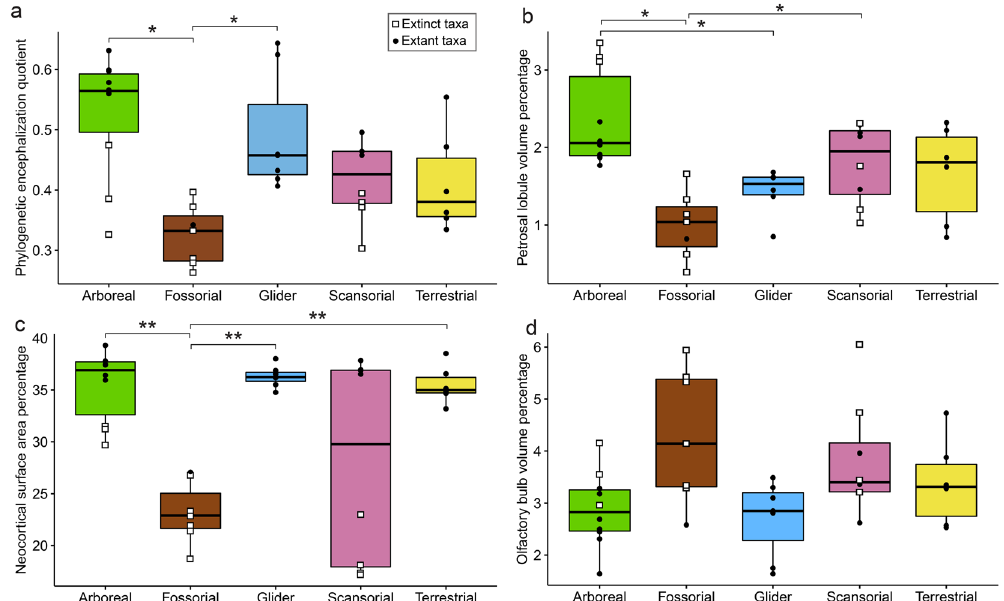
Fig. 2 Phylogenetic Encephalization Quotient and brain component percentage comparisons among locomotor groups for Sciuroidea. Boxplots of the ( a ) Phylogenetic Encephalization Quotient (PEQ); b Neocortical surface area percentage; c petrosal lobule volume percentage; d olfactory bulb volume percentage for our sample of rodents categorized by locomotor mode. * are for categories that are signi fi cantly different based on the Asymptotic K- Sample Fisher-Pitman Permutation Test (Table 1). n = 38 for a , b , and d and n = 37 for c